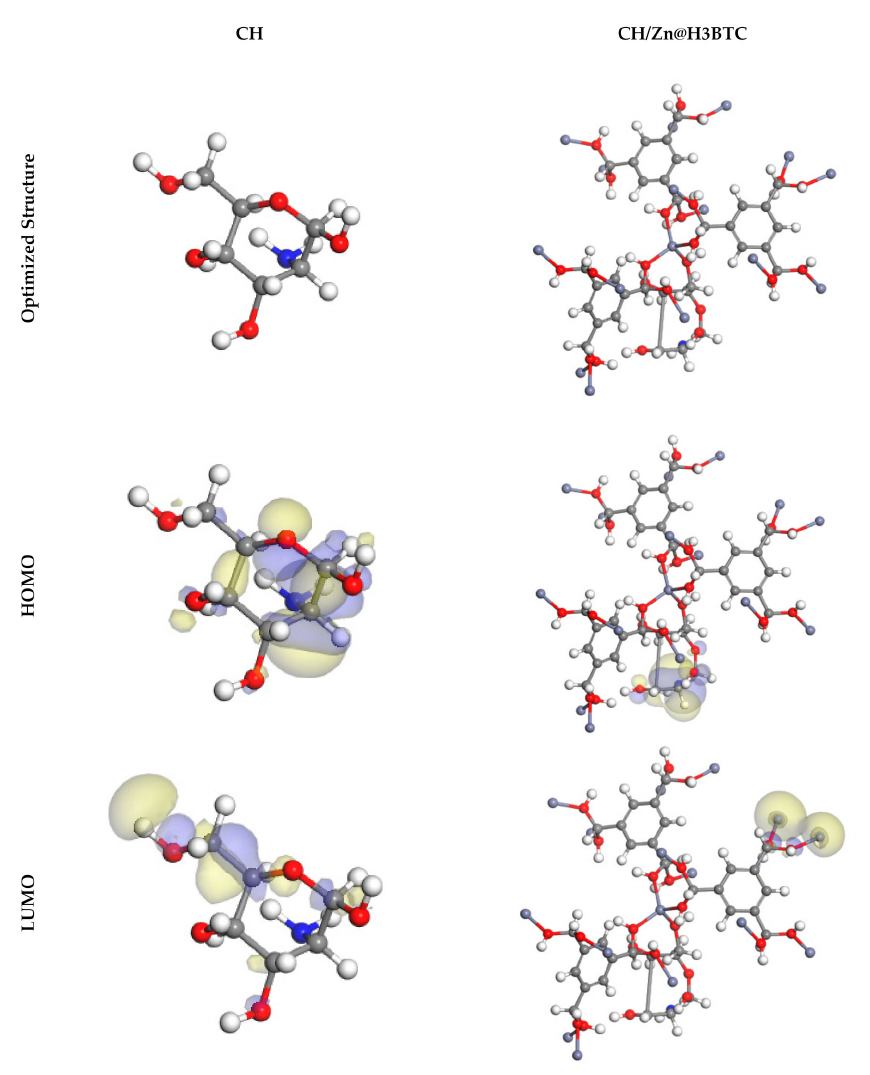
Figure 13. The molecular structures, HOMO, and LUMO of the monomer structures of CH and CH/Zn@H 3 BTC optimized using the DMol3